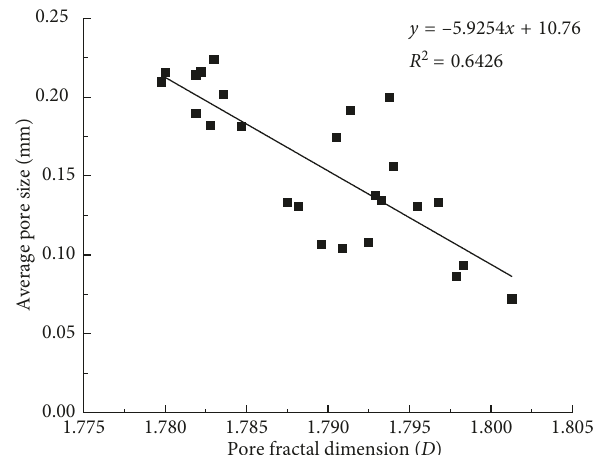
Figure 11: Relationship between pore fractal dimension and av- erage pore size.